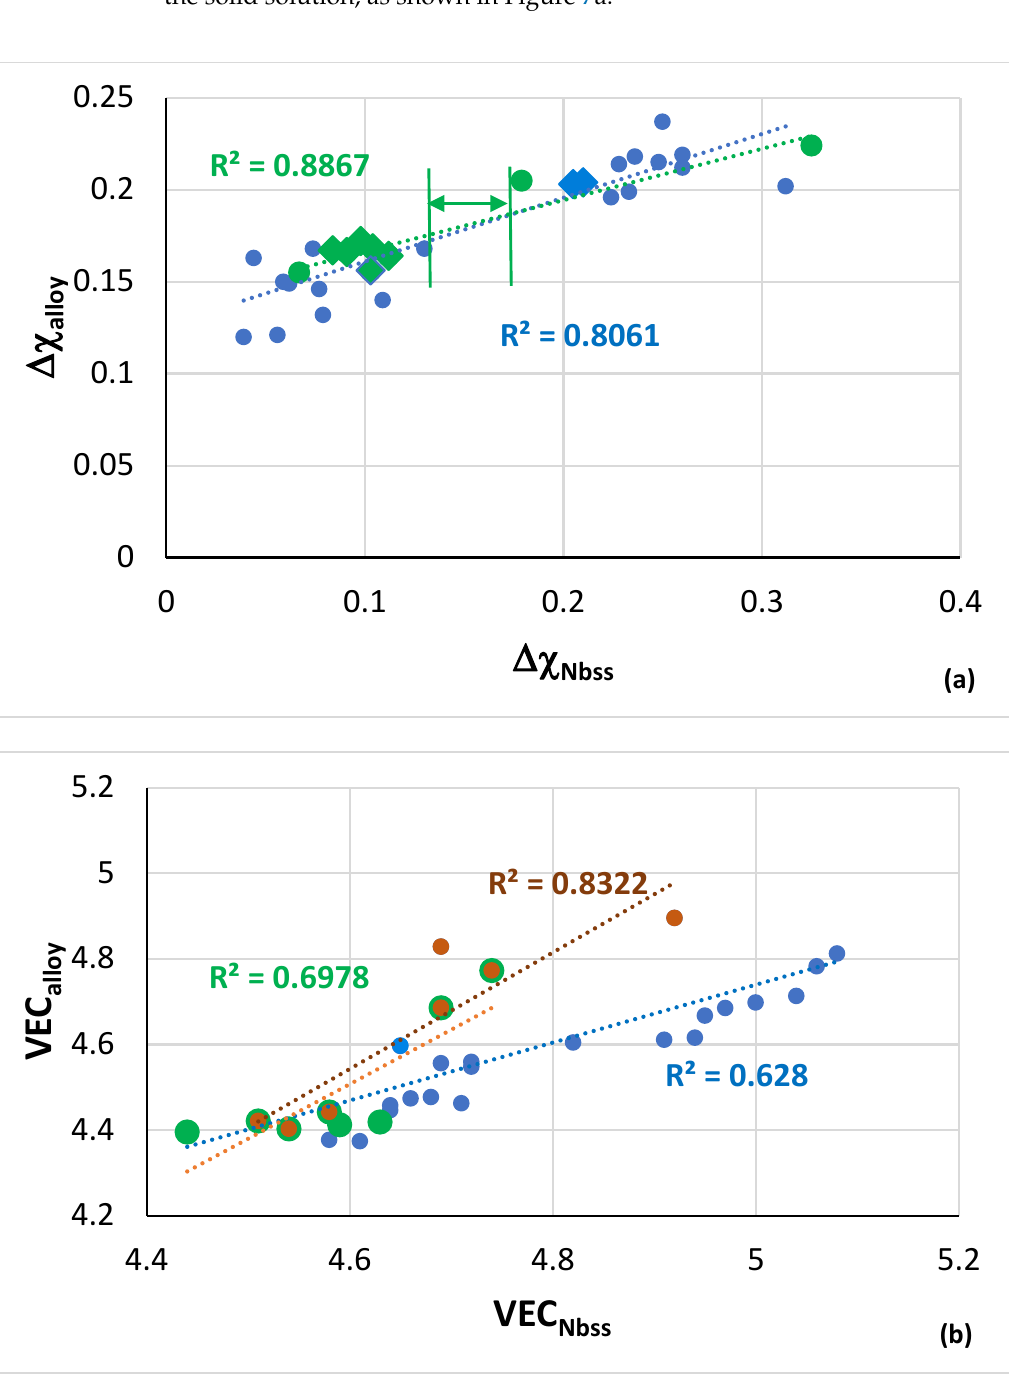
Figure 3. ( a ) ∆ χ alloy versus ∆ χ Nbss and ( b ) VEC alloy versus VEC Nbss . The data are for the same alloys as in Figure 2. In ( a ) green data points R 2 = 0.8867, all data points R 2 = 0.8061. In ( b ) the brown data points (R 2 = 0.8322) are for the alloys JN2-AC, YG8-HT, YG11-HT, TT7-AC, EZ8-AC, TT5-HT, the green data points (R 2 = 0.6978) are for the alloys JN2-AC, TT4-AC, TT7-AC, EZ8-AC, TT6-AC, ZF9-AC, TT5-AC, and the blue data points (R 2 = 0.628) are for the alloys JN2-HT, JN3, JN4, YG8-AC, YG10, YG11-AC, KZ5, KZ6-HT, JN1, TT4-HT, TT7-HT, ZF6, JG3-HT, TT8-HT (see the Appendix A for nominal alloy compositions and references). In ( a ) the diamonds indicate RM(Nb)IC/RCCA. Diamonds not shown in ( b ) for clarity of presenting the different groups. HE Nb ss in TT4-AC. Even though the same alloying additions were in the alloys and their solid solutions tions indicated with the brown data points did not contain Ge and their Ti content was not fixed at 24 at.% nominal, as is the case for the alloys represented with the green data points. Instead, they were either Ti free (alloy YG8) or their Ti concentration was lower (alloys YG10, YG11). In other words, the parameter VEC (Figure 3b) shows that not only the alloying additions but also their concentrations in an alloy are key regarding the for- mation or not of CC/HE Nb ss . Furthermore, only with the parameter VEC we can differ- entiate the data for CC/HE Nb ss and “conventional” Nb ss , as indicated with the brown and green lines compared with the blue line in Figure 3b. Thus, the co-existence of CC/HE Nb ss